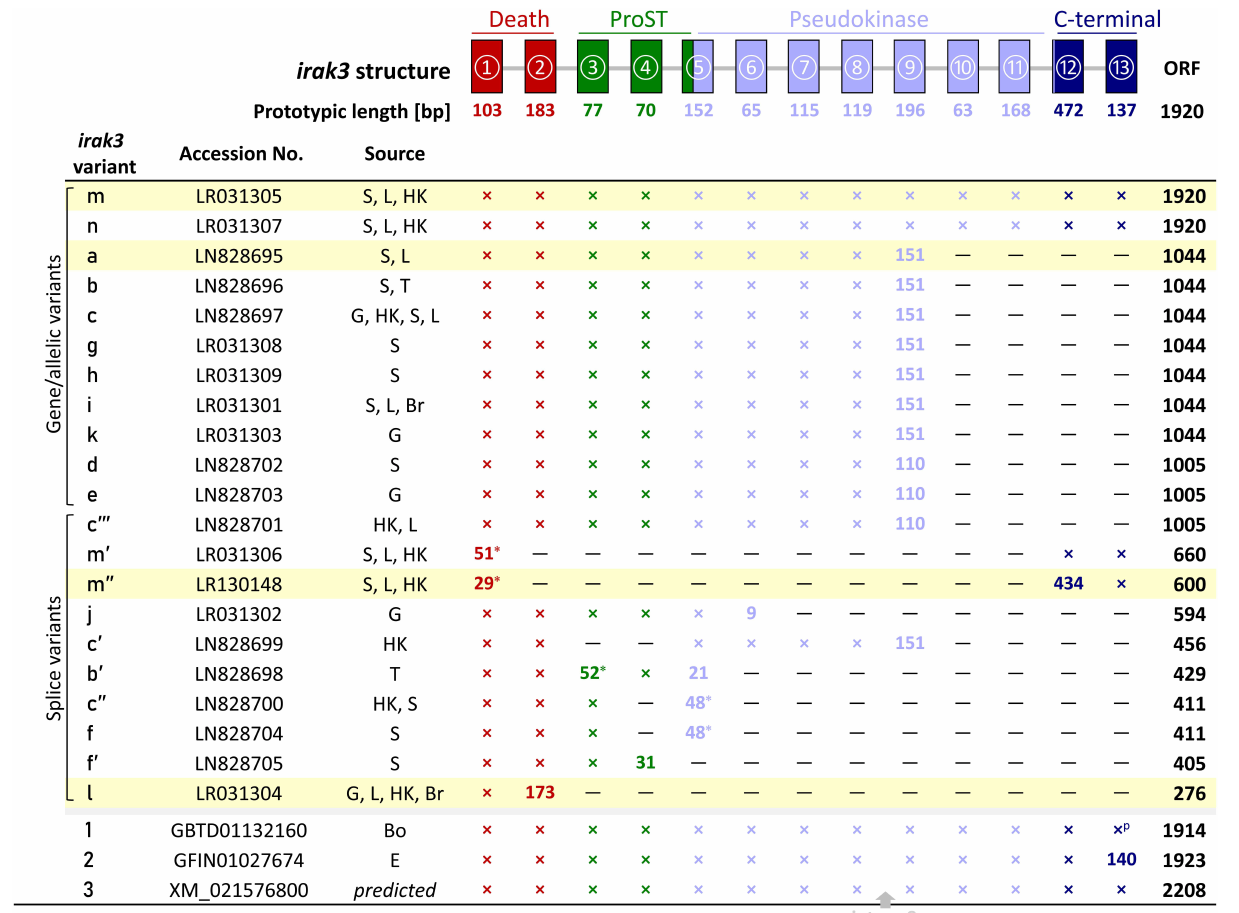
FIGURE 1 | Representation of the different irak3 -transcript lengths. The irak3 -variants of trout are listed together with their accession numbers and their tissue-wise occurrence on the left. Tissues are abbreviated as follows: Bo, bone; Br, brain; E, unfertilized eggs; G, gills; HK, head kidney; L, liver; S, spleen; T, thymus. The genomic organization of the trout irak3 gene is drawn above the scheme. Exons are represented by colored boxes (red, death domain; green, ProST region; light blue, pseudokinase domain; dark blue, C-terminal domain). Lines between exons represent introns. A cross indicates that the respective exon is present in the listed transcript variant; if the exon length differs from the prototypic length, the actual length is given (in nt); a superscript p denotes a partial 3 ′ -end. The position where a fragment of intron 8 was inserted in the predicted irak3 variant ( 3) is marked with a gray arrow. Asterisks indicate the possible usage of alternative splice acceptor/donor sites. The color of the characters denotes a particular protein domain. Fields highlighted in yellow indicate clones, which were functionally analyzed in later experiments (see Figures 5 – 7